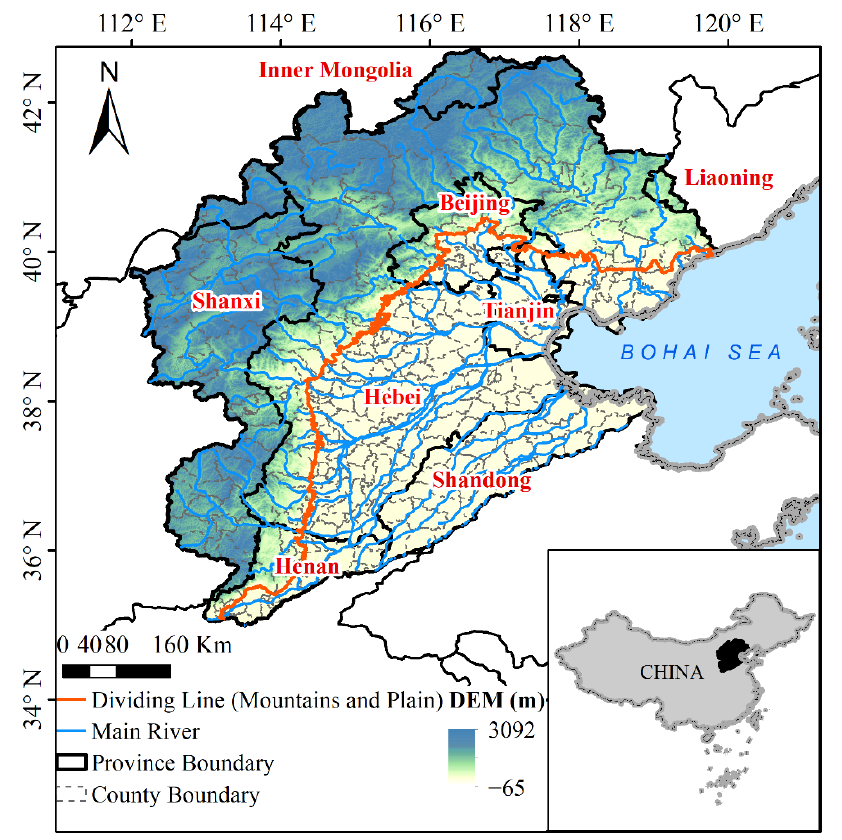
Figure 1. Location of the study area, along with 334 county boundaries.